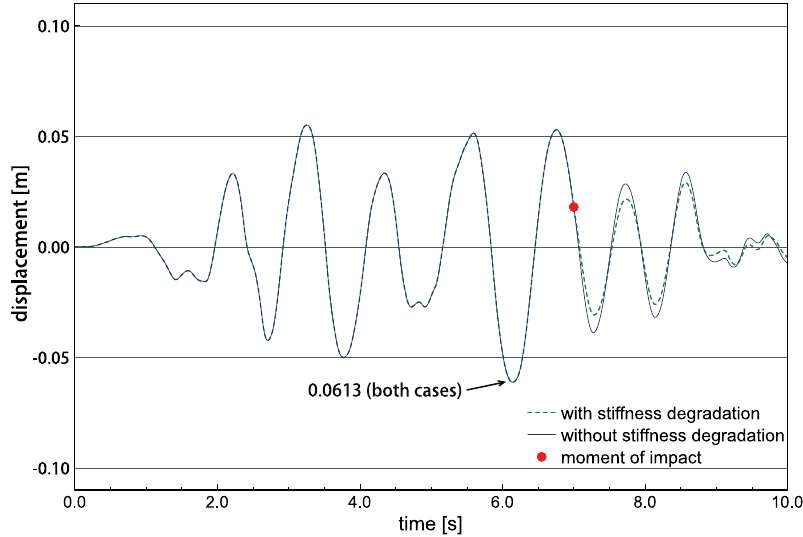
Fig. 11. Displacement time history of the first story of building under the El Centro earthquake with and without considering the degradation of horizontal stiffness for impact at t = 7 s. the model of impact force defined in Eqs